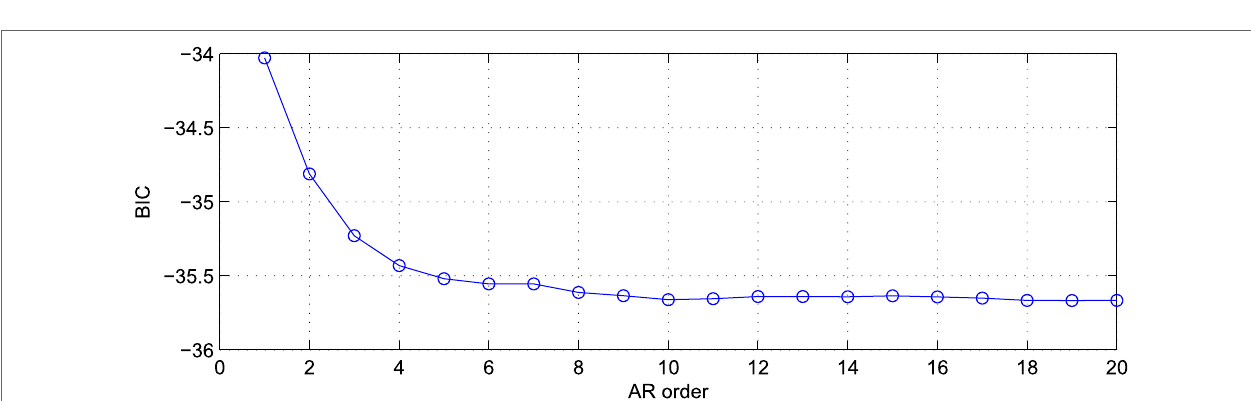
monitoring campaign was planned and organized in